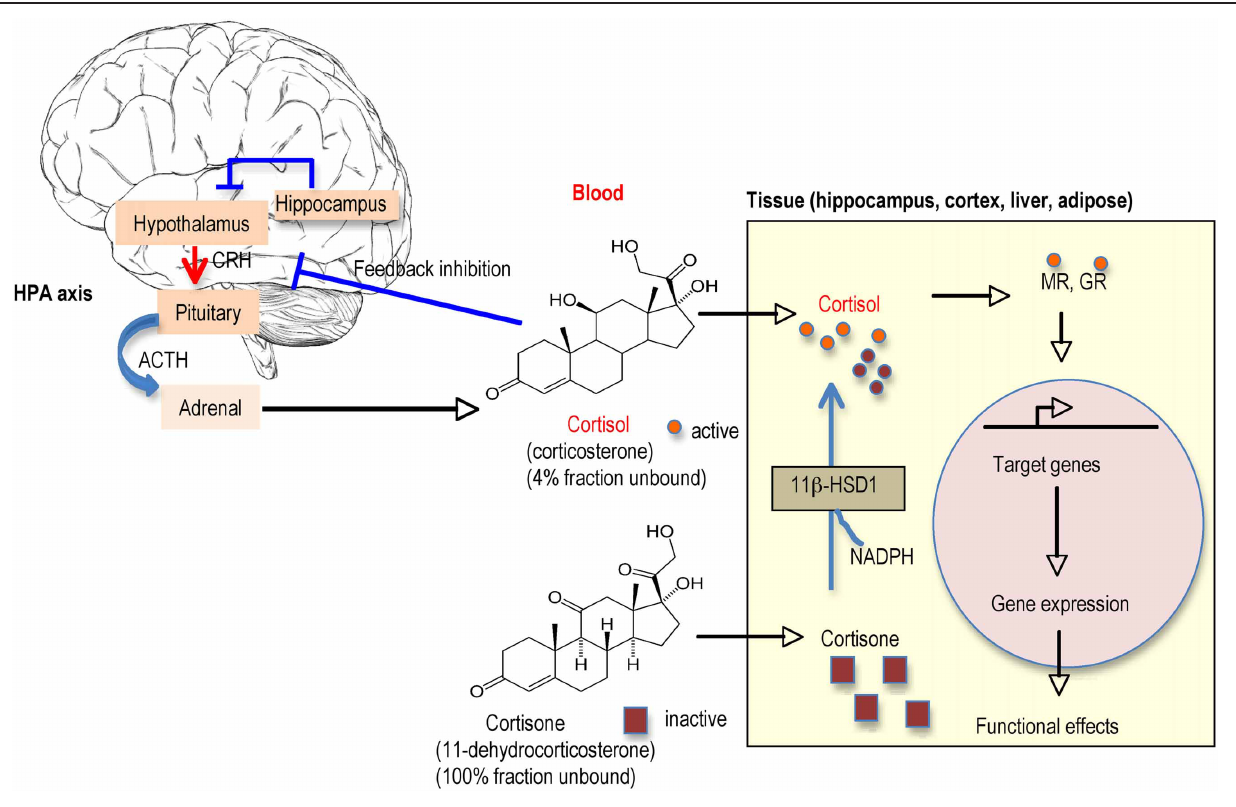
FIGURE 4 | Regulation of glucocorticoid (GC) levels in blood and tissues. Circulating GC levels are tightly regulated by negative feedback inhibition at the hypothalamic-pituitary-adrenal (HPA) axis. Active GCs (cortisol in humans, corticosterone in rodents) circulate mostly bound to CBG (corticosteroid binding globulin) such that only ∼ 4% are free to enter tissues. The inactive GCs (cortisone, 11-dehydrocorticosterone) the products of 11 β -HSD2 metabolism mainly in kidney, circulates unbound to plasma proteins so all are